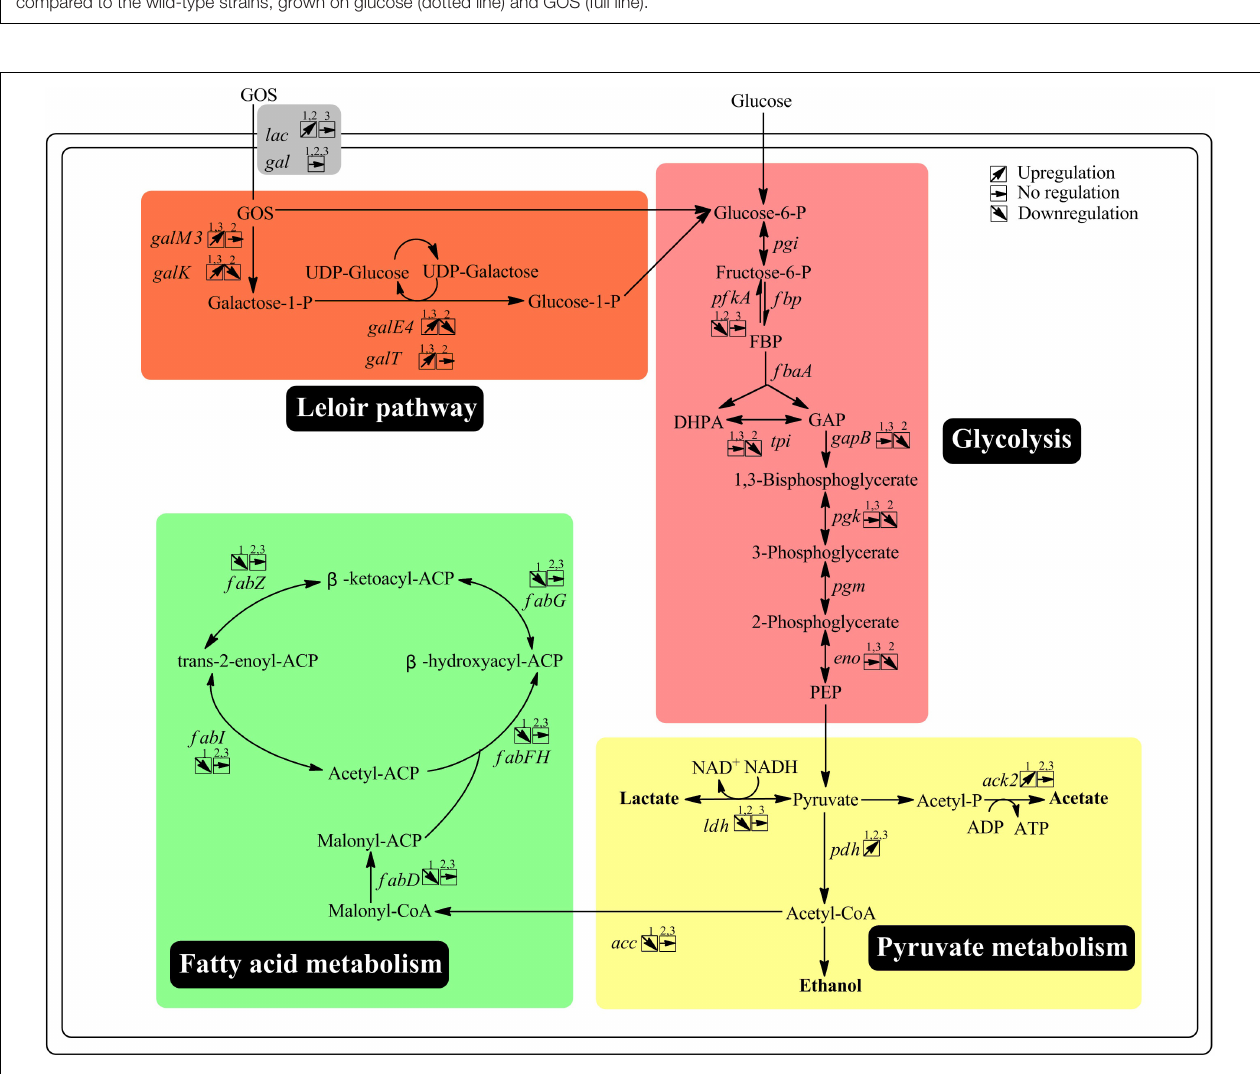
FIGURE 4 | Overview of the key genes with altered expression and their related pathways via transcriptome analysis. 1, The wild-type strain grown on GOS versus the wild-type strain grown on glucose; 2, the ccpA mutant grown on GOS versus the ccpA mutant grown on glucose; 3, the ccpA mutant grown on GOS versus the wild-type strain grown on GOS. Gene annotation downloaded from NCBI: galM3, aldose 1-epimerase; galK, galactokinase; galE4, UDP-glucose 4-epimerase; galT, UDPglucose–hexose-1-phosphate uridylyltransferase; pgi, glucose-6-phosphate isomerase; fbp, fructose-1,6-bisphosphatase; pfkA, 6-phosphofructokinase; fbpA, fructose-bisphosphate aldolase; tpi, triose-3-phosphate isomerase; gapB, glyceraldehyde-3-phosphate dehydrogenase; pgk, phosphoglycerate kinase; pgm, phosphoglycerate mutase; eno, enolase; pyk, pyruvate kinase; ldh, L-lactate dehydrogenase; pfl, pyruvate formate-lyase; pdh, pyruvate dehydrogenase; pox, pyruvate oxidase; pta, phosphotransacetylase; ack, acetate kinase; acc, acetyl-CoA carboxylase; fabD, ACP-S-malonyltransferase; fabF, 3-oxoacyl-ACP synthase II; fabH, 3-oxoacyl-ACP synthase III; fabG, 3-oxoacyl-ACP reductase; fabZ, (3R)-hydroxymyristoyl-ACP dehydratase; fabI, enoyl-ACP reductase.